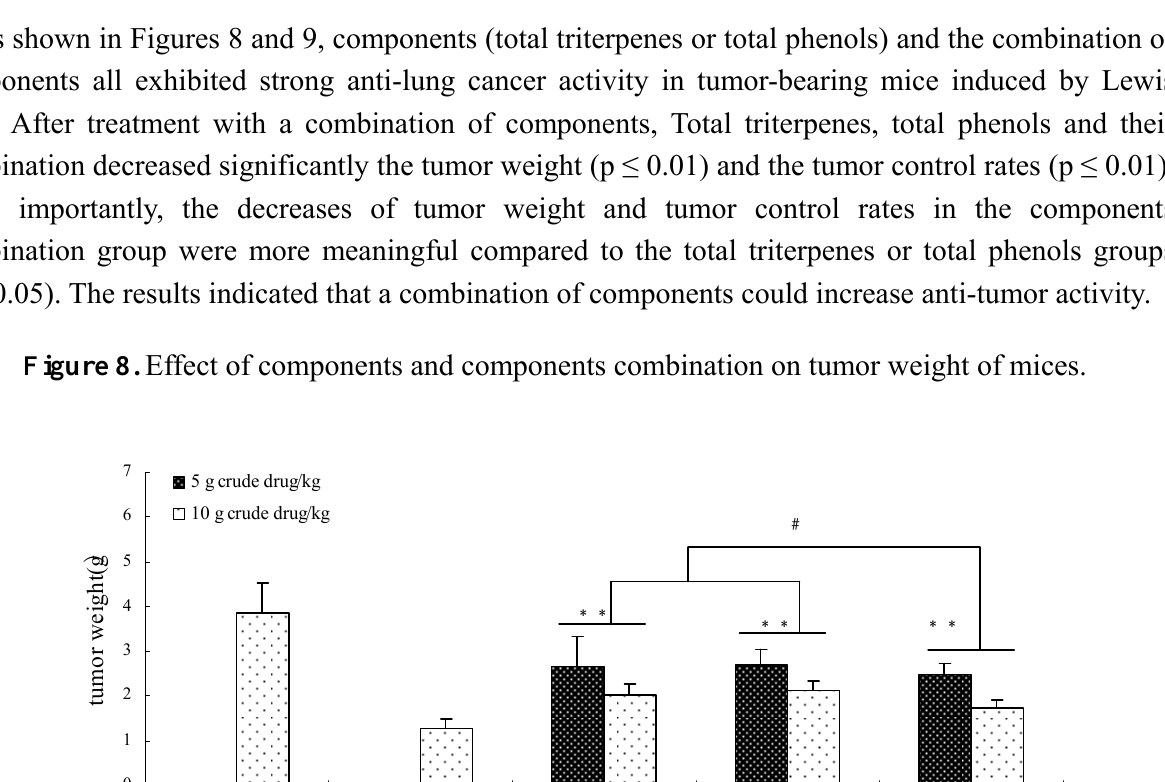
“A” represents “total triterpenes”, “B” represents “total phenols”. **p ≤ 0.01, “A”, “B” and “A+B” vs. blank control group; #p ≤ 0.05 “A+B” vs. “A” & “B”. All date were taken from two individual experiments and expressed as mean±SD (n =